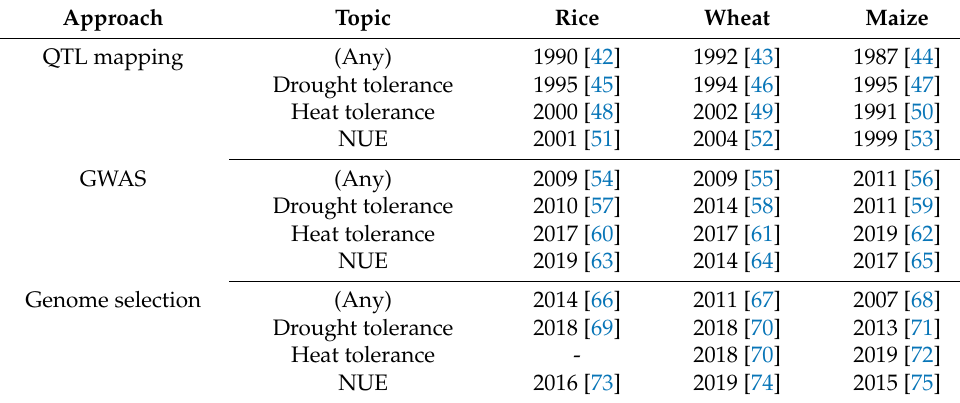
Table 1. Year and bibliographic reference of the first documented application of different marker- assisted breeding approaches in rice, wheat, and